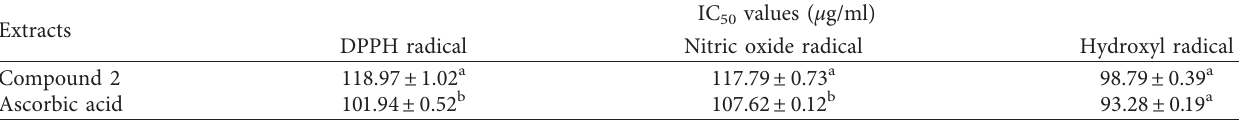
Table 1: Free radical scavenging capacities of compound 2 from ethanolic extract of E. crispa